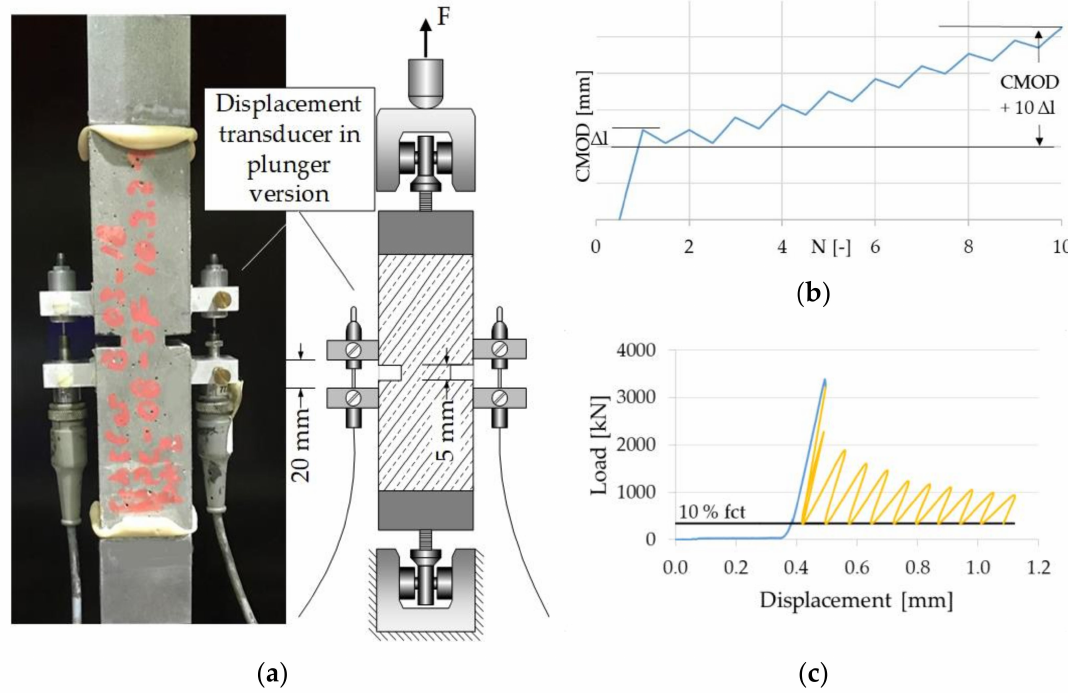
Figure 4. Experiment on notched prismatic specimen: ( a ) Tensile test setup: real and schematic; ( b ) test regime of crack opening controlled tests; ( c ) example of the loading procedure for the crack opening